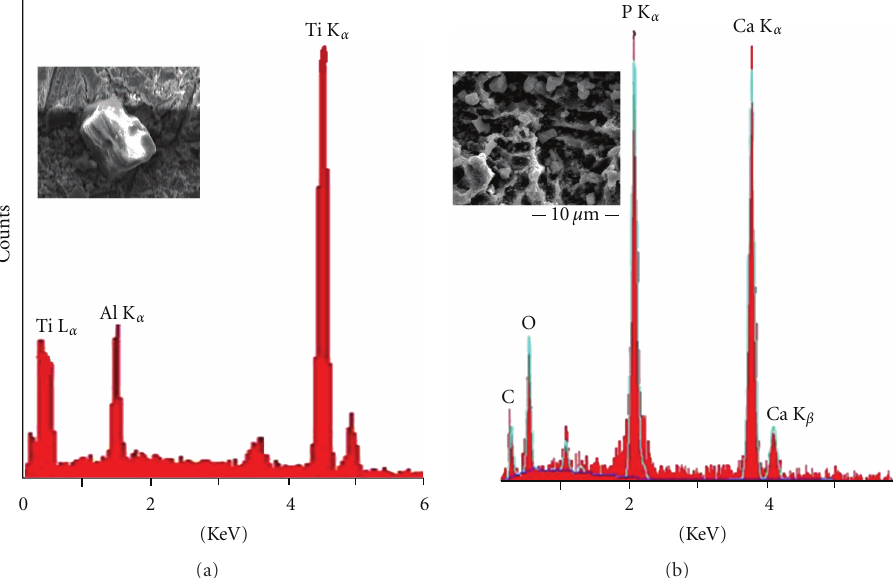
Figure 3: (a) Results of spectrum showing the surfaces having alumina particles in the test groups after 10/30 sec of blasting/etching. (b) EDS showing the surfaces having high levels of Ca and P atoms without alumina through secondary blasting of TTCP particles.